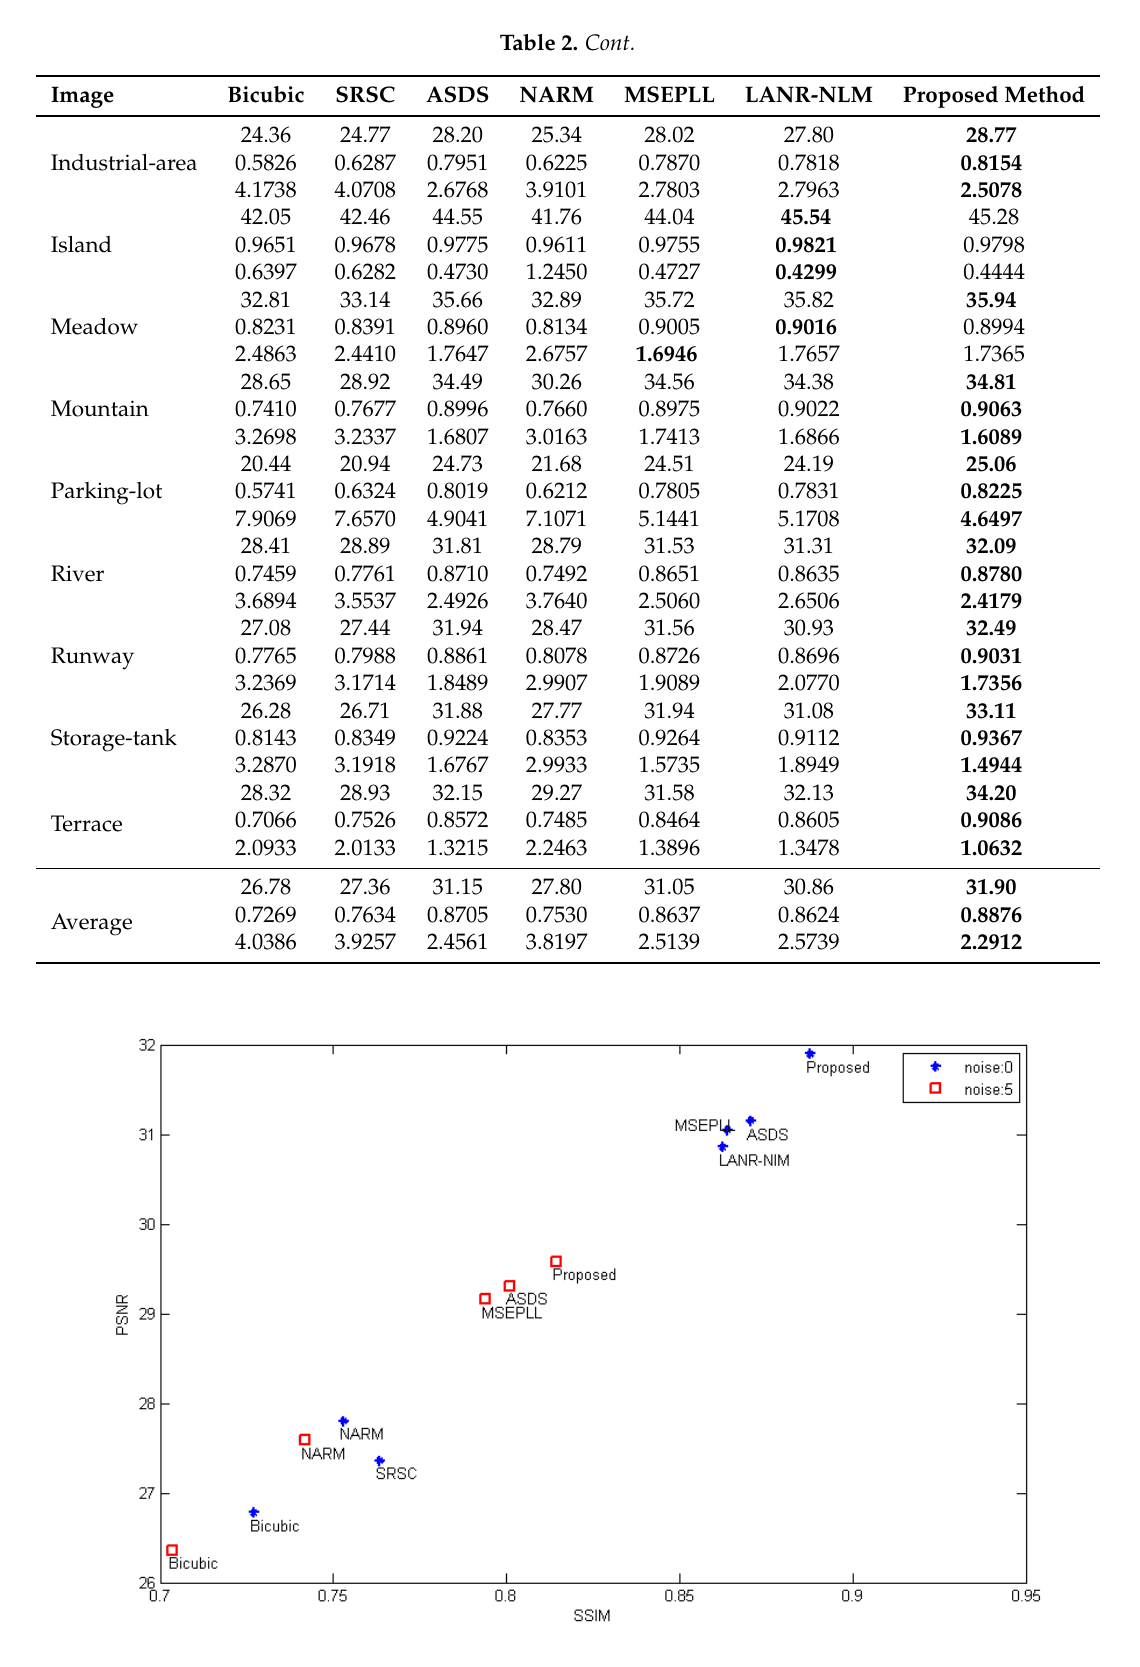
Figure 4. The average objective indices for the test images in the case of noise = 0 and noise =